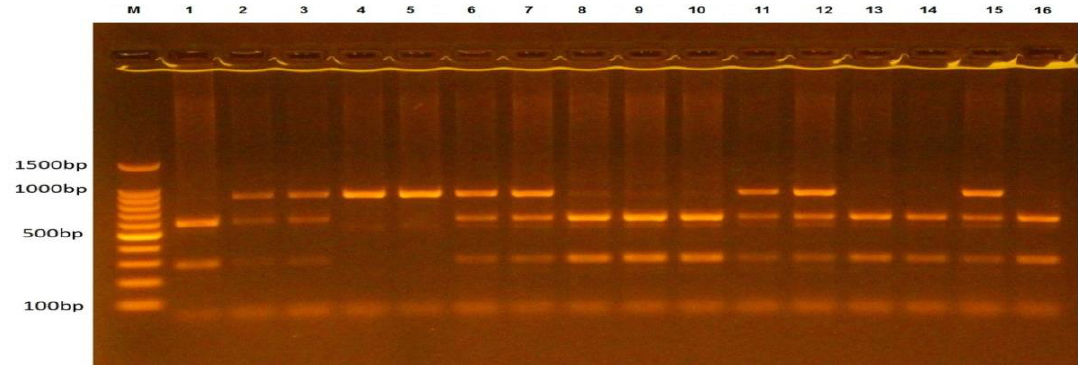
Figure 2. Electrophoresis pattern of PCR product digested with Bsa I restriction enzyme, 2% agarose gel in local goats. Lanes 1,8,9,10,13,14,16 show homozygous CC genotype; Lanes 2,3,6,7,11,12,15 are heterozygous AC genotype. Lanes 4,5 are homozygous AA genotype. M: DNA molecular marker 100 bp size. Ethidium Bromide stained bands in the gel Table 2. Distribution of MTNR1A gene polymorphism in male and female kids of local goats Polymorphism No. goats